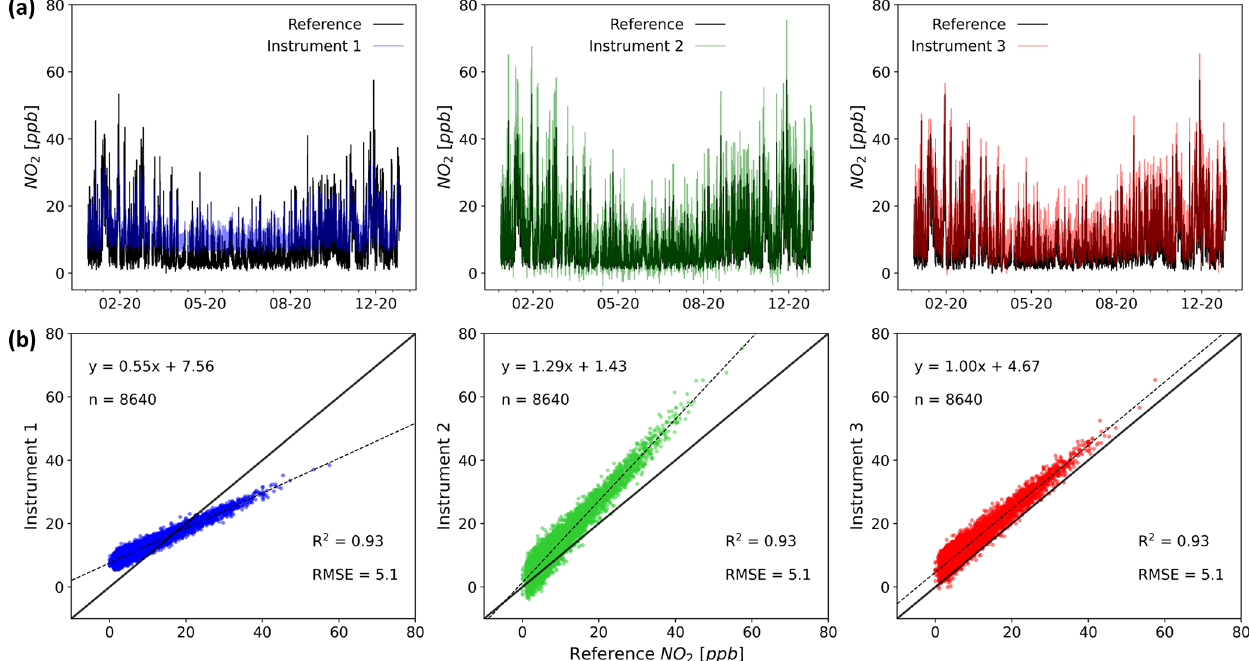
Figure 2. Time series (a) and regression (b) plots for three hypothetical instruments and a reference (1 year of data). The most used metrics for evaluating the performance of LCS ( R 2 and RMSE) are identical for the systems shown, even when the errors have very different characteristics (time resolution